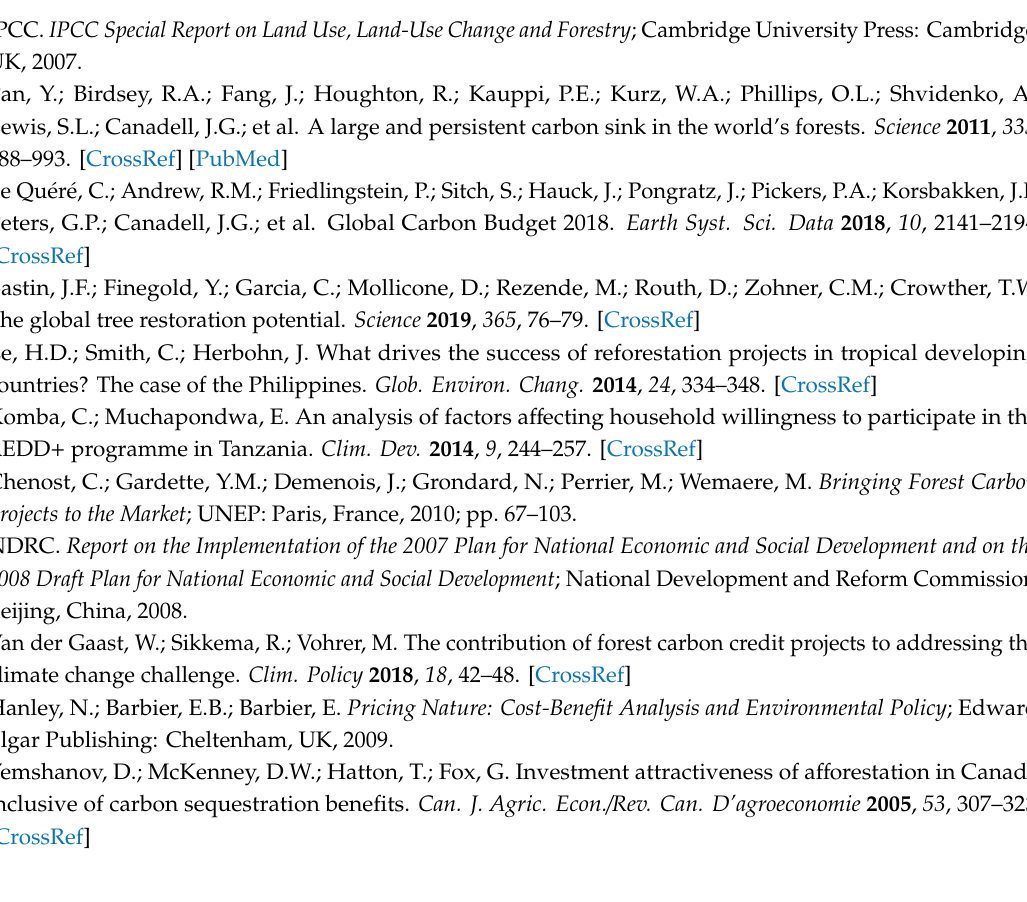
Figure S1. Temporal patterns of the amount of carbon sequestration (including biomass and soil carbon) after a ff orestation with various tree types on